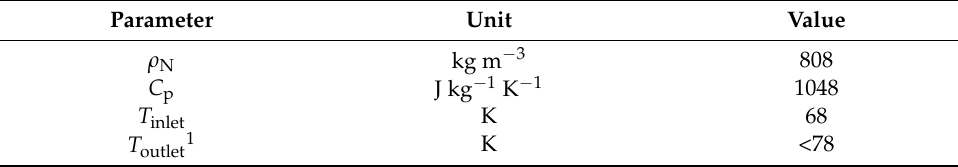
Table 1. Physical parameters used in the calculation of the hydraulic losses.